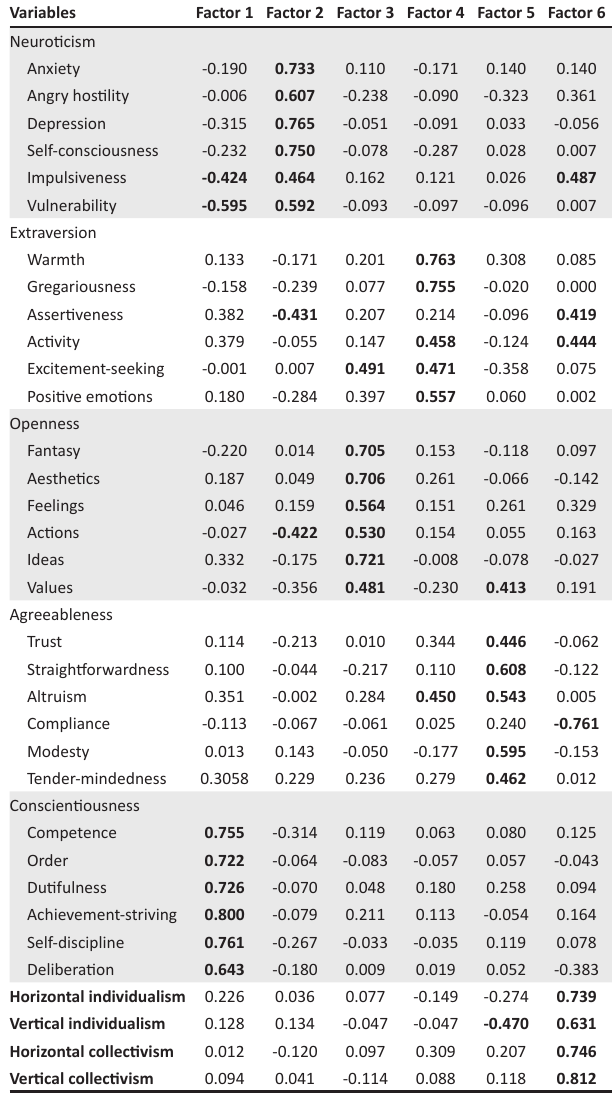
TABLE 5: Six-factor solution for the joint factor analysis of the NEO-PI-3 and the individualism and collectivism dimensions.